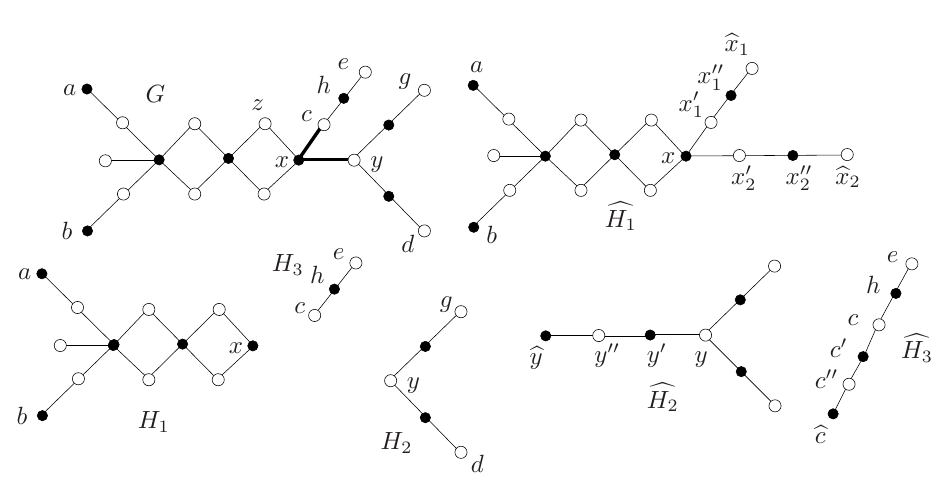
Fig. 3: A bipartite graph G with X the darkened vertices. The darkened edges cx and xy are cut-edges of G 2 − and hence belong to E − . The set { a, b, x } is an ATX and { z, g, d } is an ATY. G is not a probe interval graph because it has an induced T 3 , but Γ = G − { c, h, e } is not a probe interval graph because Γ − xy has an ATX in (cid:98) H 1 and an ATY in (cid:98) H 2 which requires that { x, y } ⊂ N